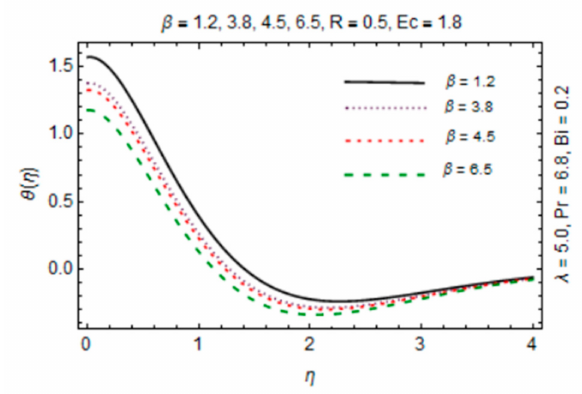
Figure 11. β verses temperature profile.